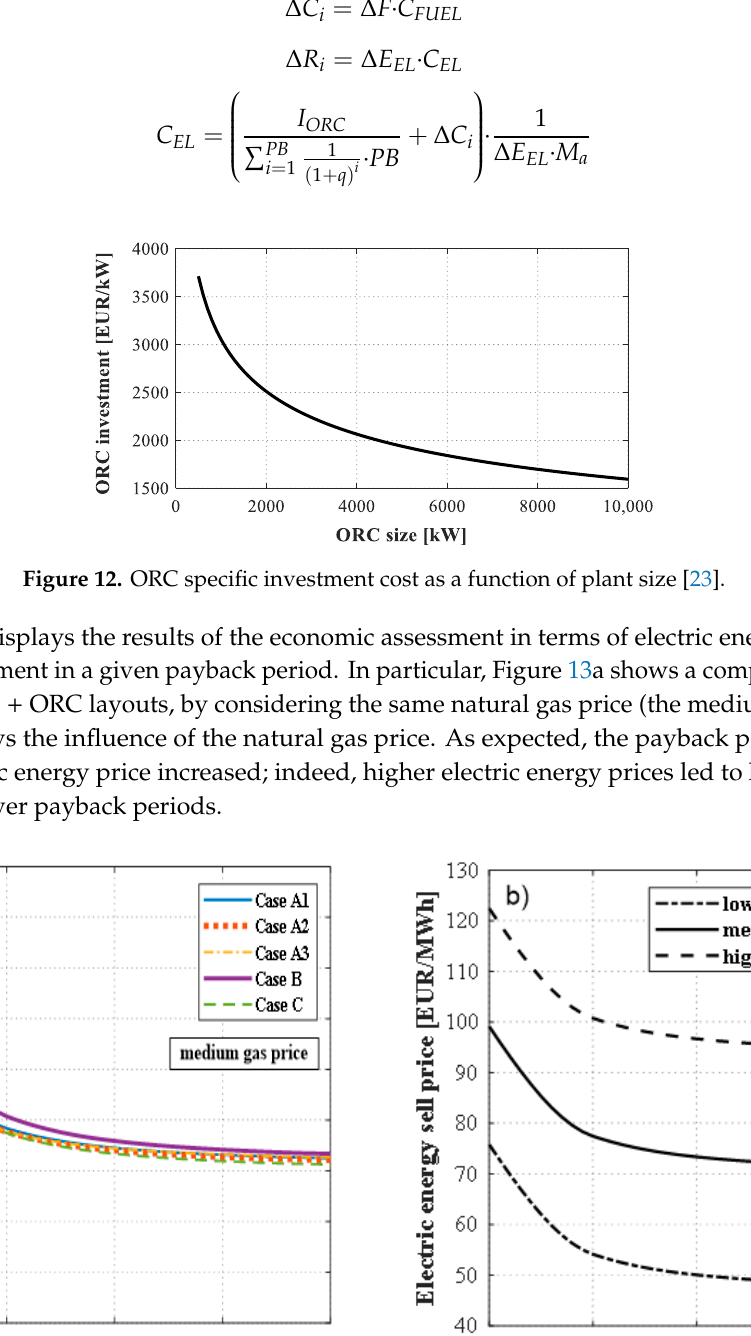
Figure 12. ORC specific investment cost as a function of plant size [23].